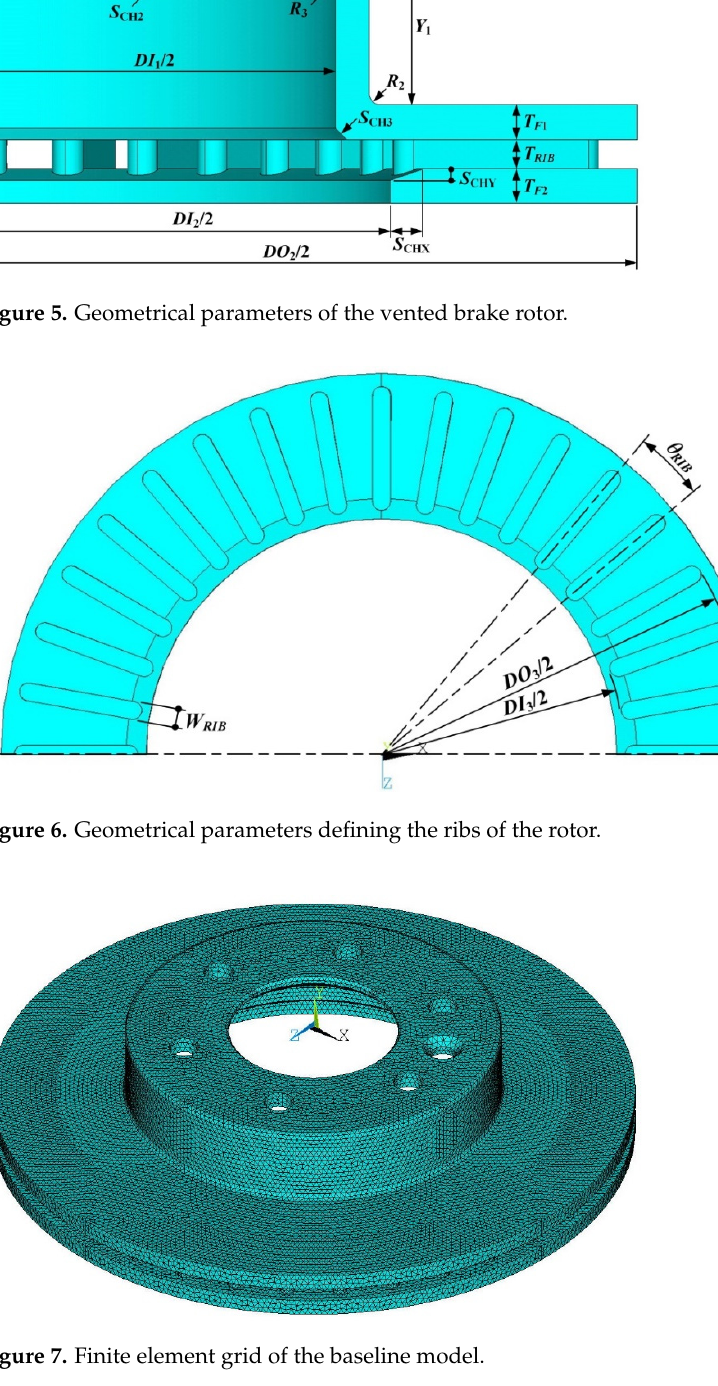
Figure 7. Finite element grid of the baseline model.